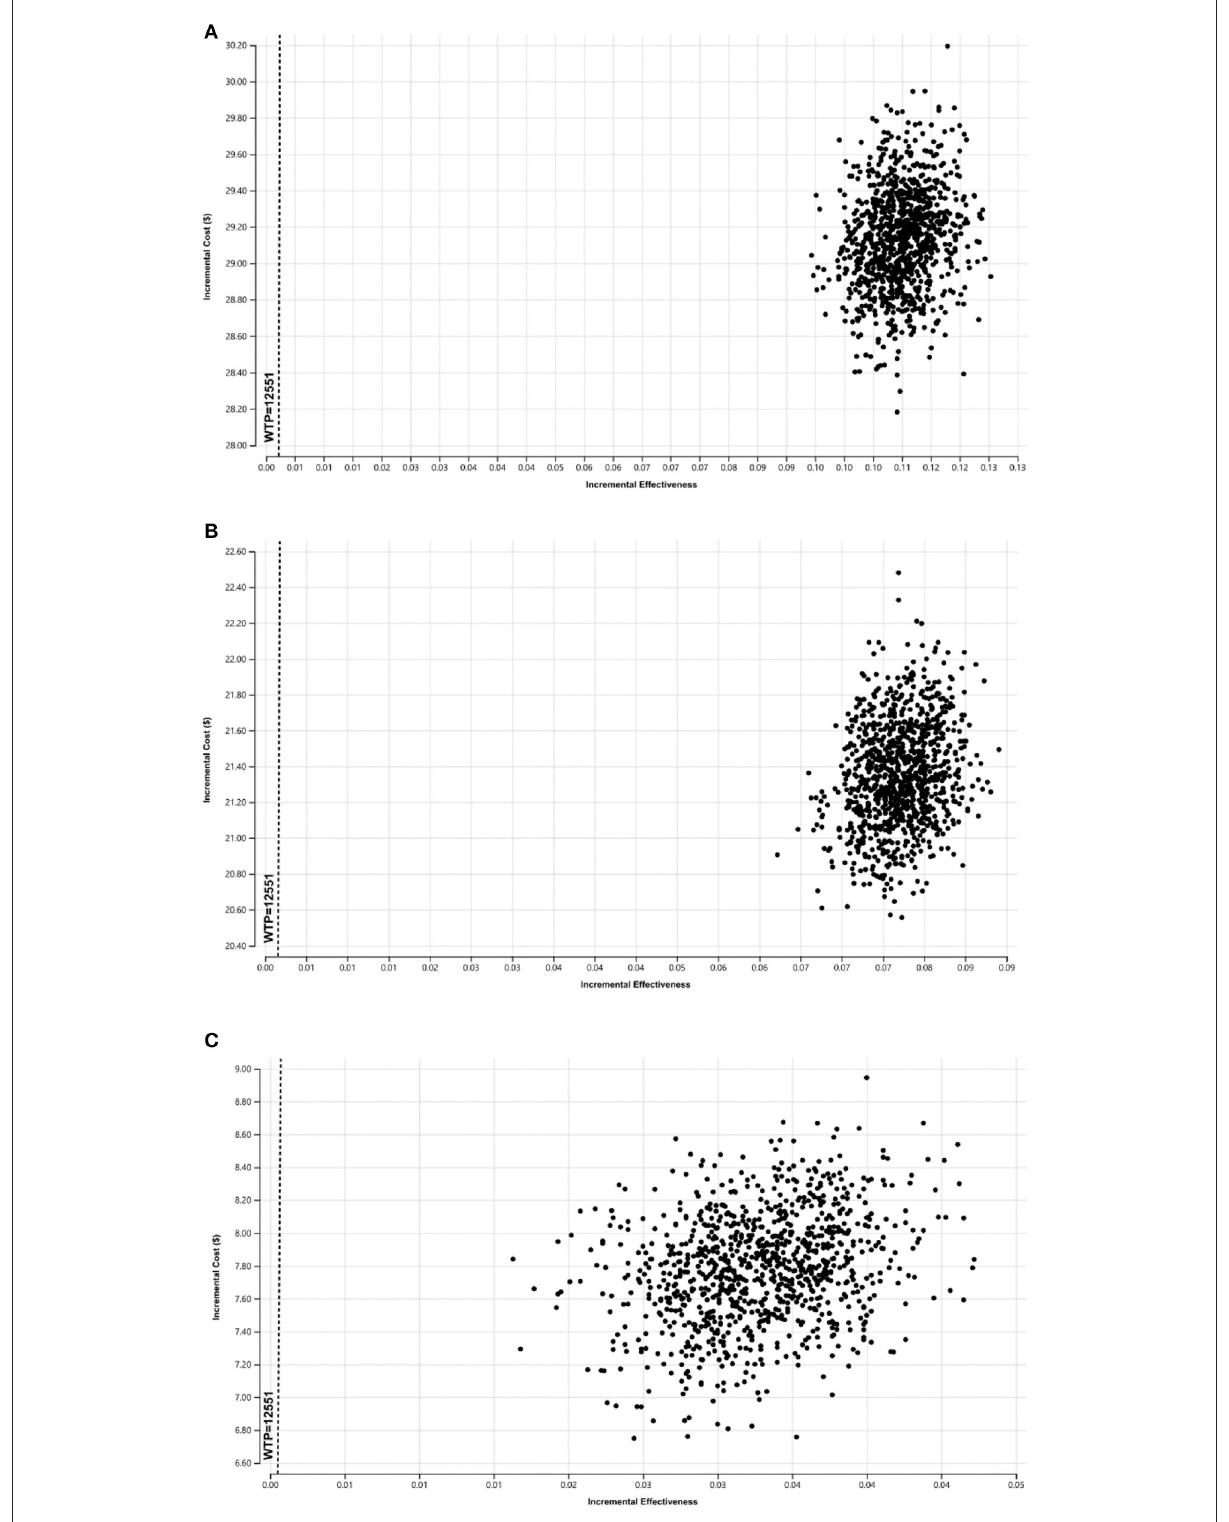
FIGURE3 The probabilistic sensitivity results of the ICER in difference of screening strategies, (A) is the ICER of strategy 1 compared to the control group, (B) is the ICER of strategy 2 compared to the control group, (C) is the ICER of screening strategy 1 compared to the strategy 2.